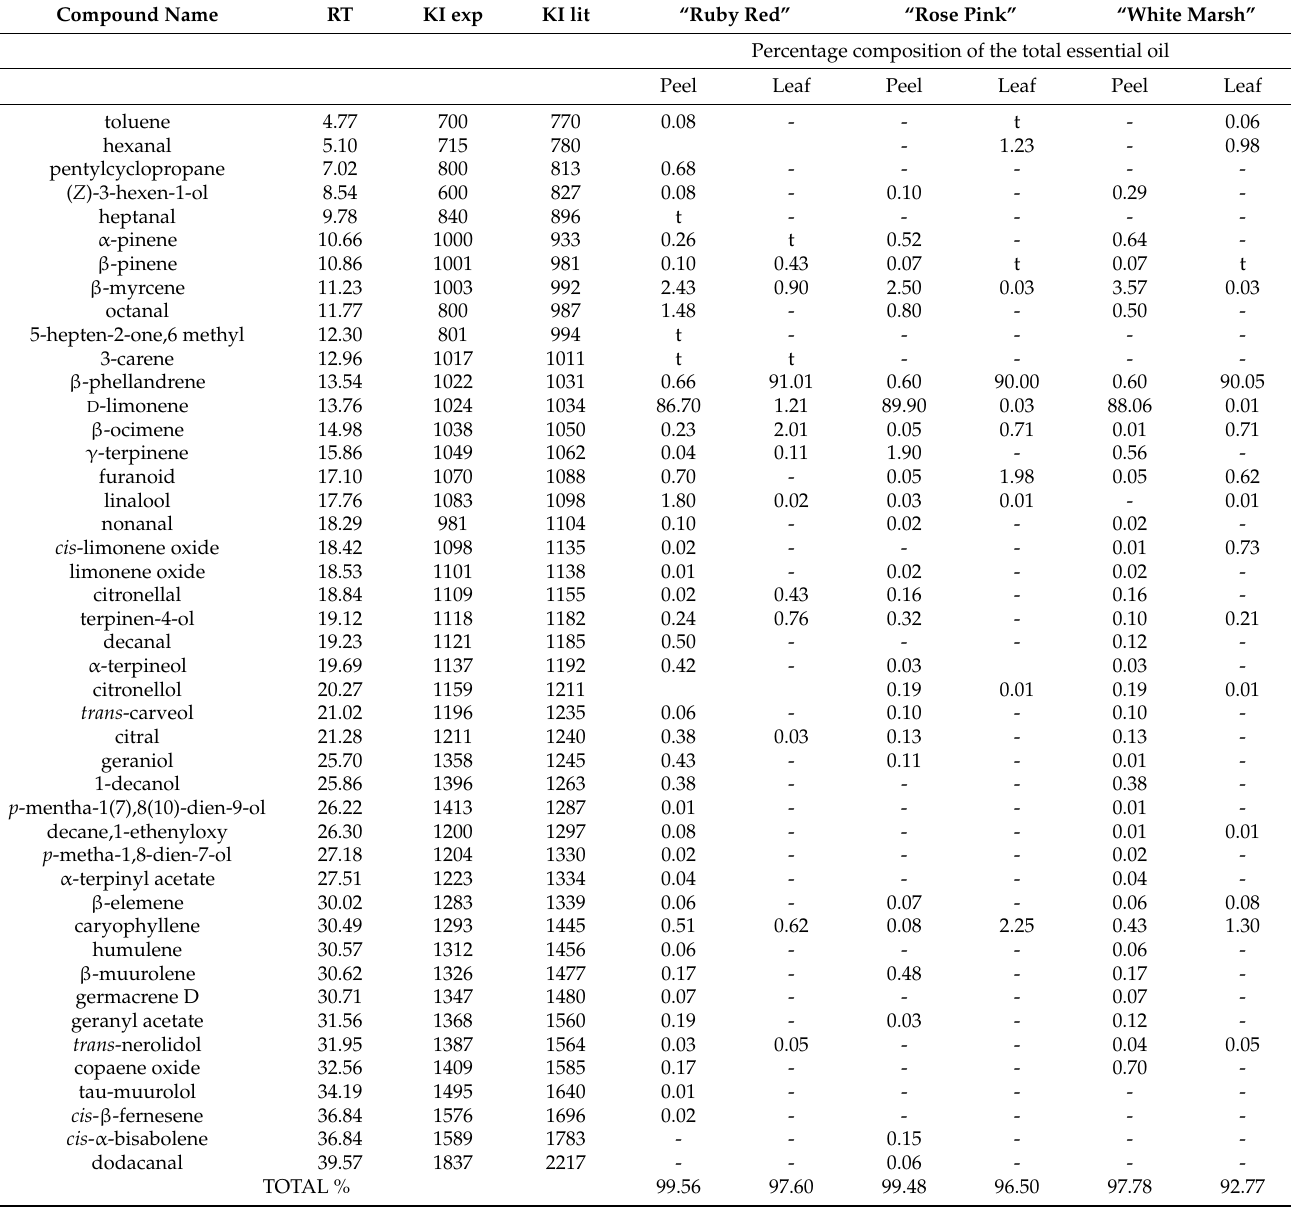
Table 2. Chemical composition of the essential oils from three Citrus paradisi